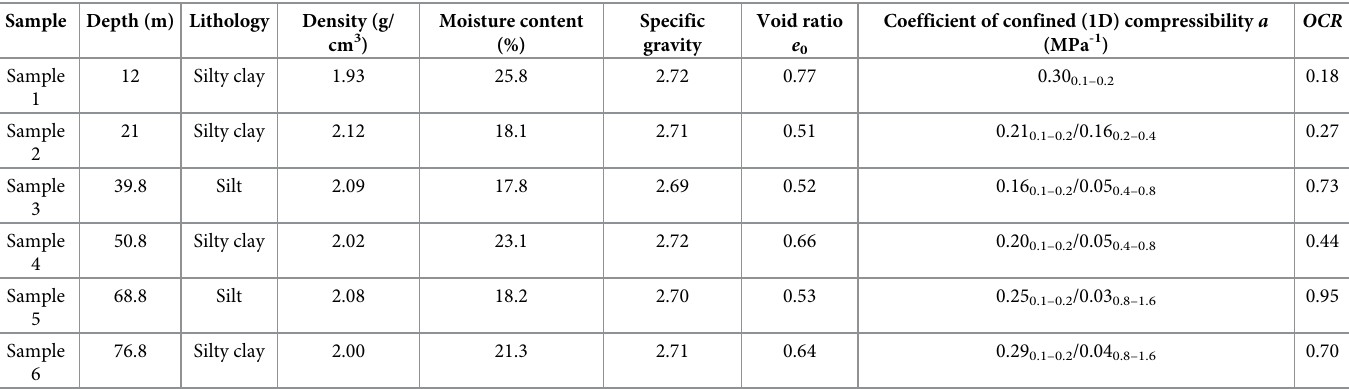
Table 1. Physical and mechanical properties of each soil sample.